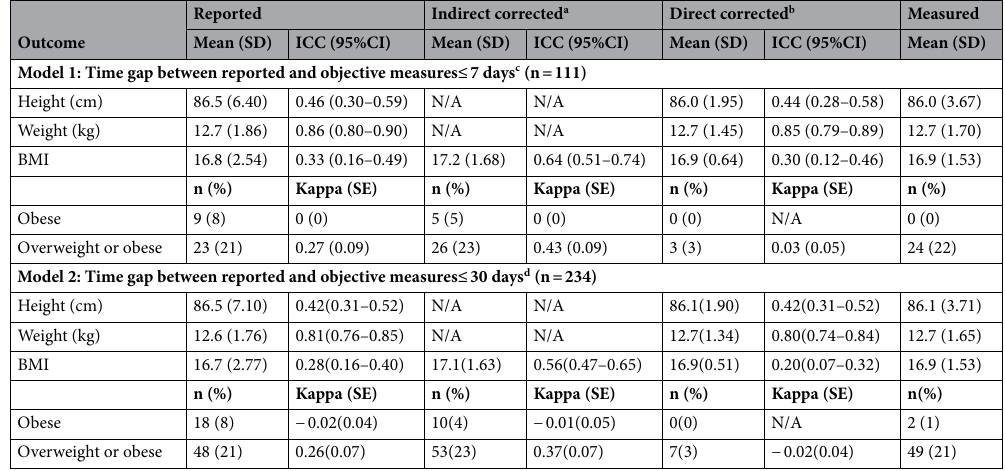
Table 5. Intra-class correlation coefficients (ICCs) and kappa statistics between reported, corrected and measured outcomes. a Indirect correction used the corrected weight and Height values to calculate corrected BMI. b Direct correction used the corrected weight, height and BMI predicted by the model. c Only included reported and measured anthropometrics within 7 days. d Only included reported and measured anthropometrics within 30